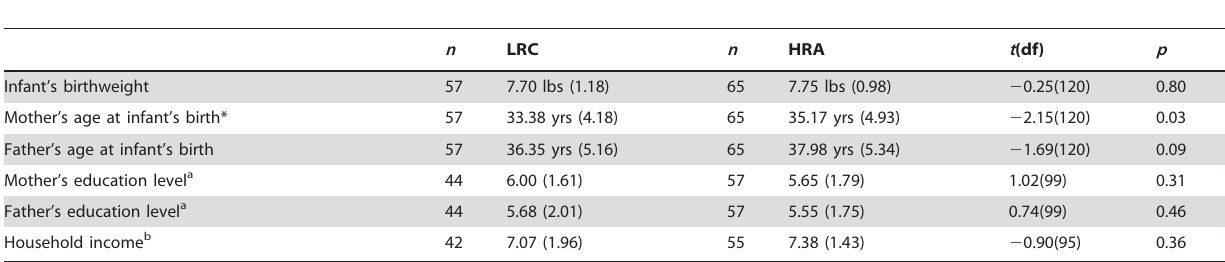
Table 1. Comparison of infants in the low risk control group (LRC) and the high risk for autism group (HRA) on demographic characteristics.